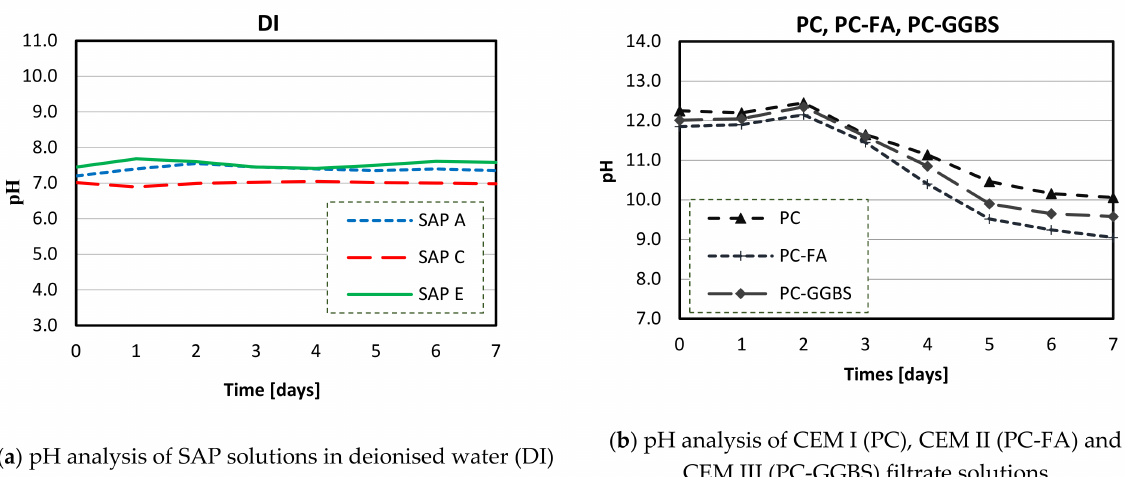
Figure 10. pH analysis of SAP in deionised (DI) water ( a ) and pH analysis of cements filtrate solutions ( b